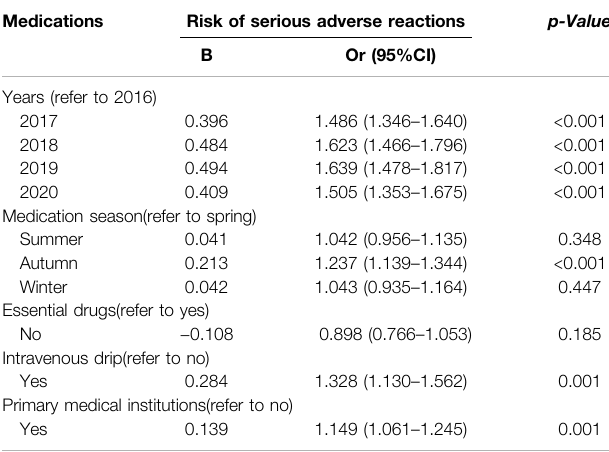
Tables 6 , 7 analyze the sample characteristics, medication methods, TCM injections, and medication reasons at different levels. The results of strati fi ed analysis showed that the population